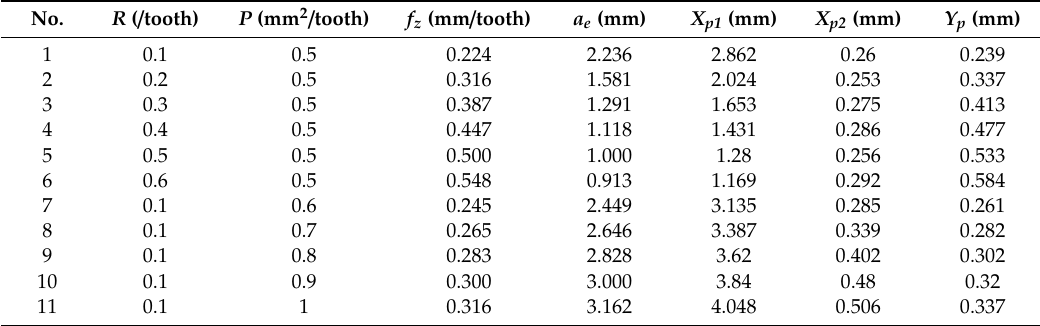
Table 8. Wavelength corresponding to the peaks of the power spectral density (PSD) profile ( v c = 250 m / min, a p = 0.2